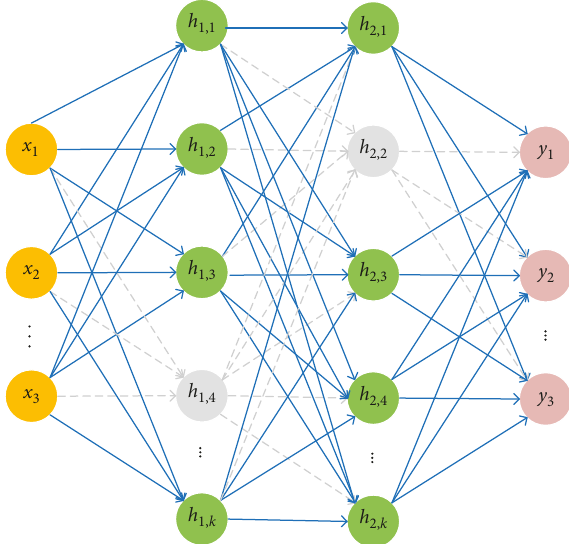
Figure 8: Dropout ANN used in the